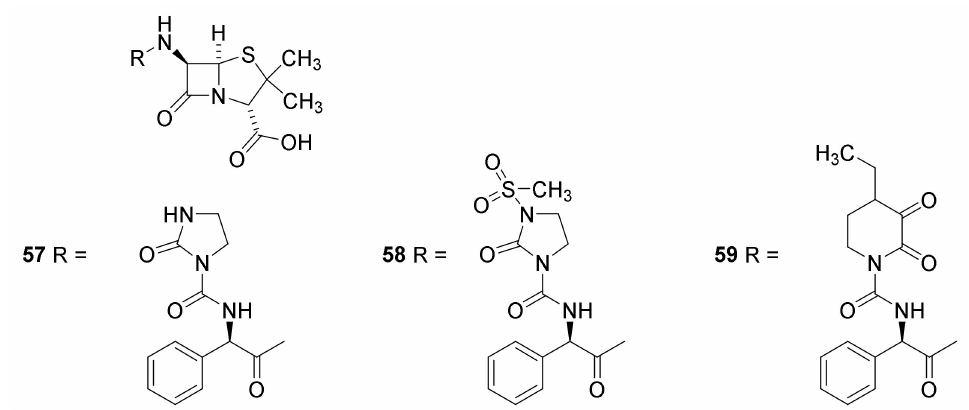
Figure 13. Ureidopenicillins: Azlocillin ( 51 ), mezlocillin ( 52 ) and piperazillin ( 53 ) [38].